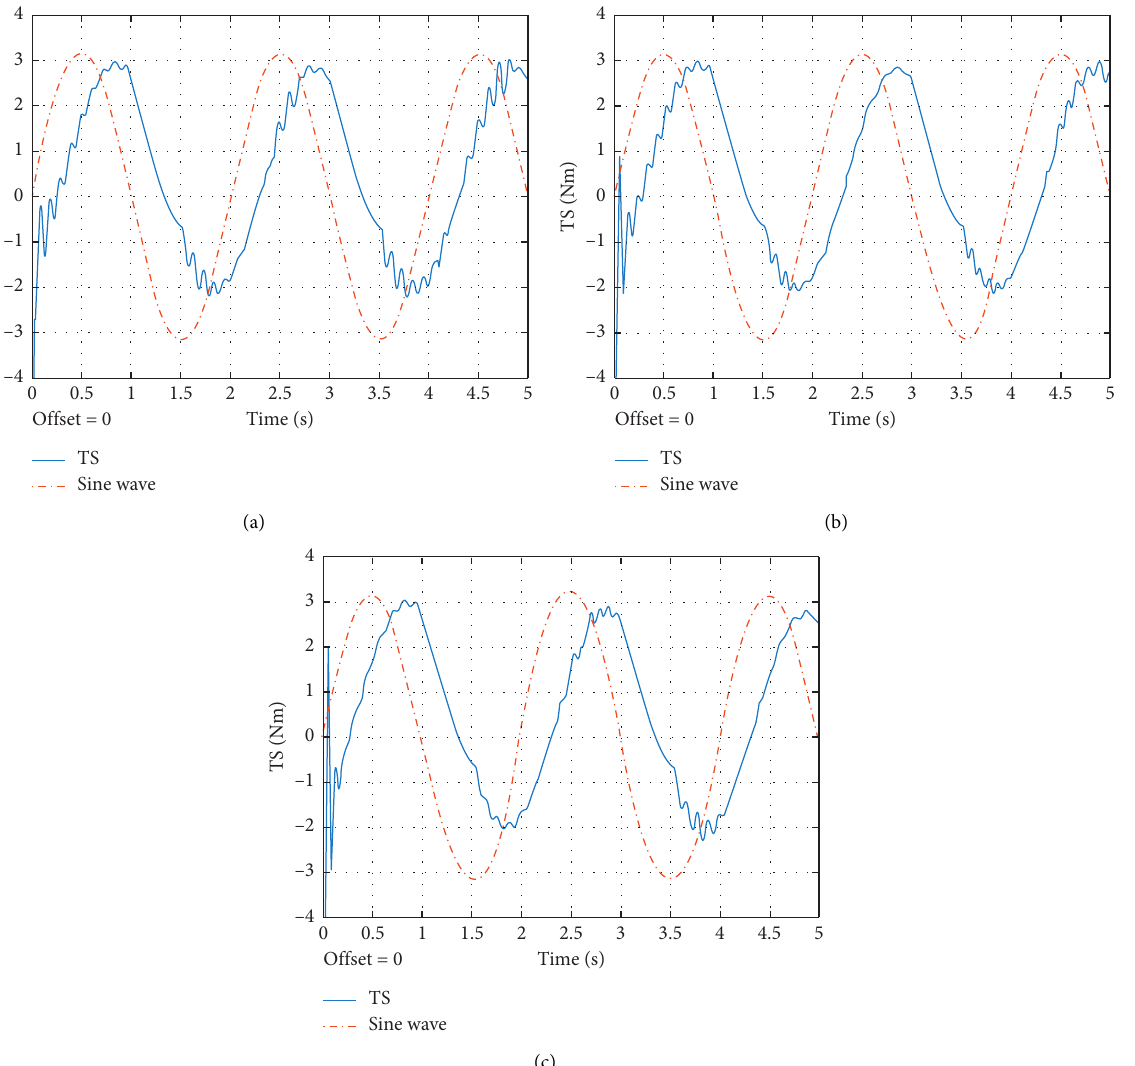
Figure 8: Simulation result of (a) controller 1, (b) controller 2, and (c) controller